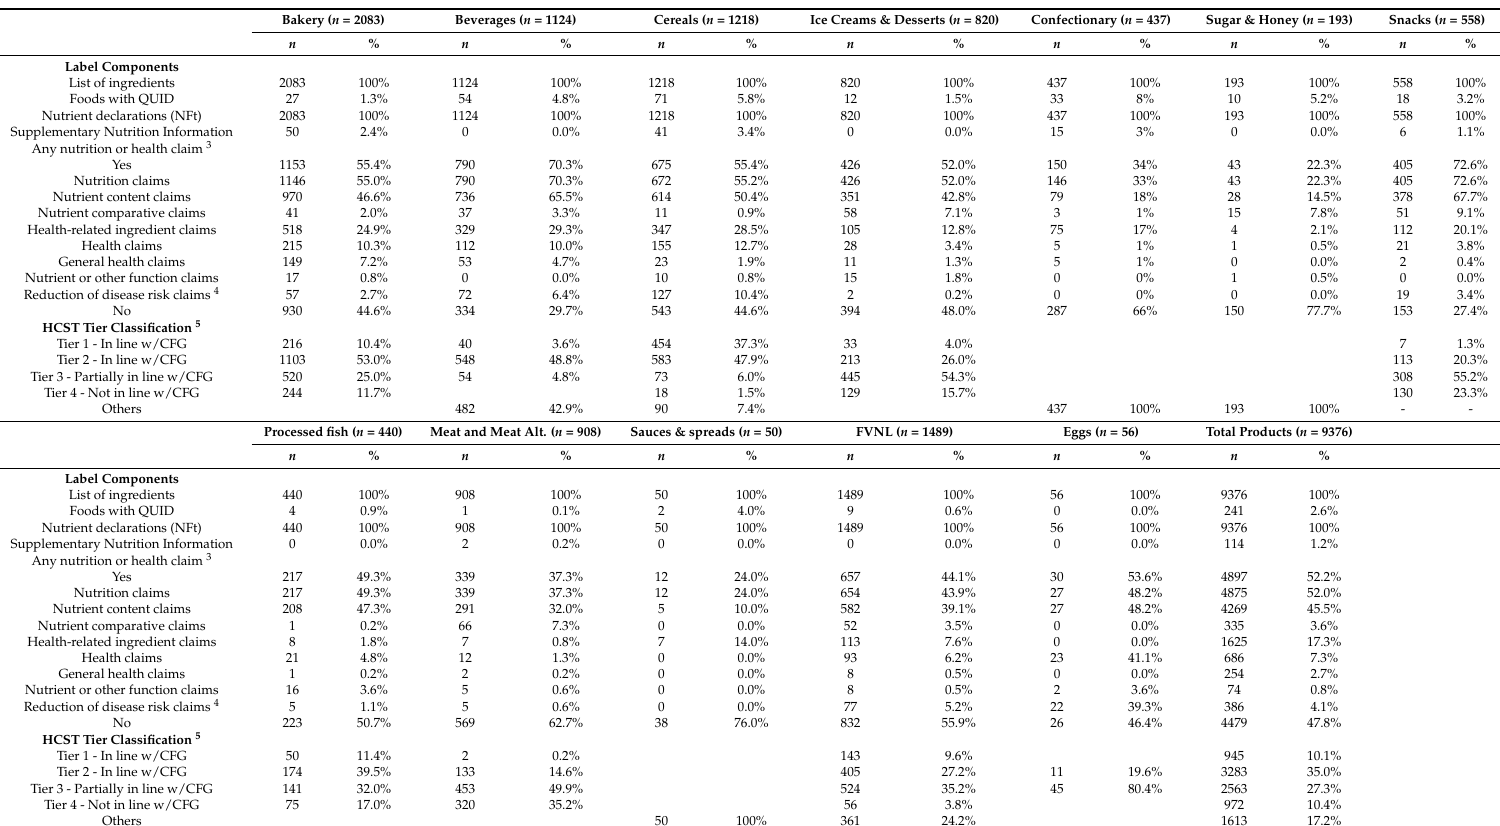
Table 2. Proportions of label components and HCST Tier classification on a sample of Canadian packaged foods ( n = 9376) 1,2,3